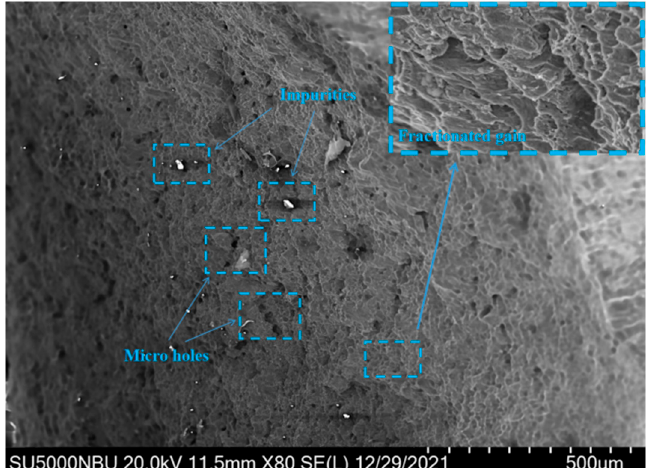
Figure 13. Fracture diagram of tensile specimen.